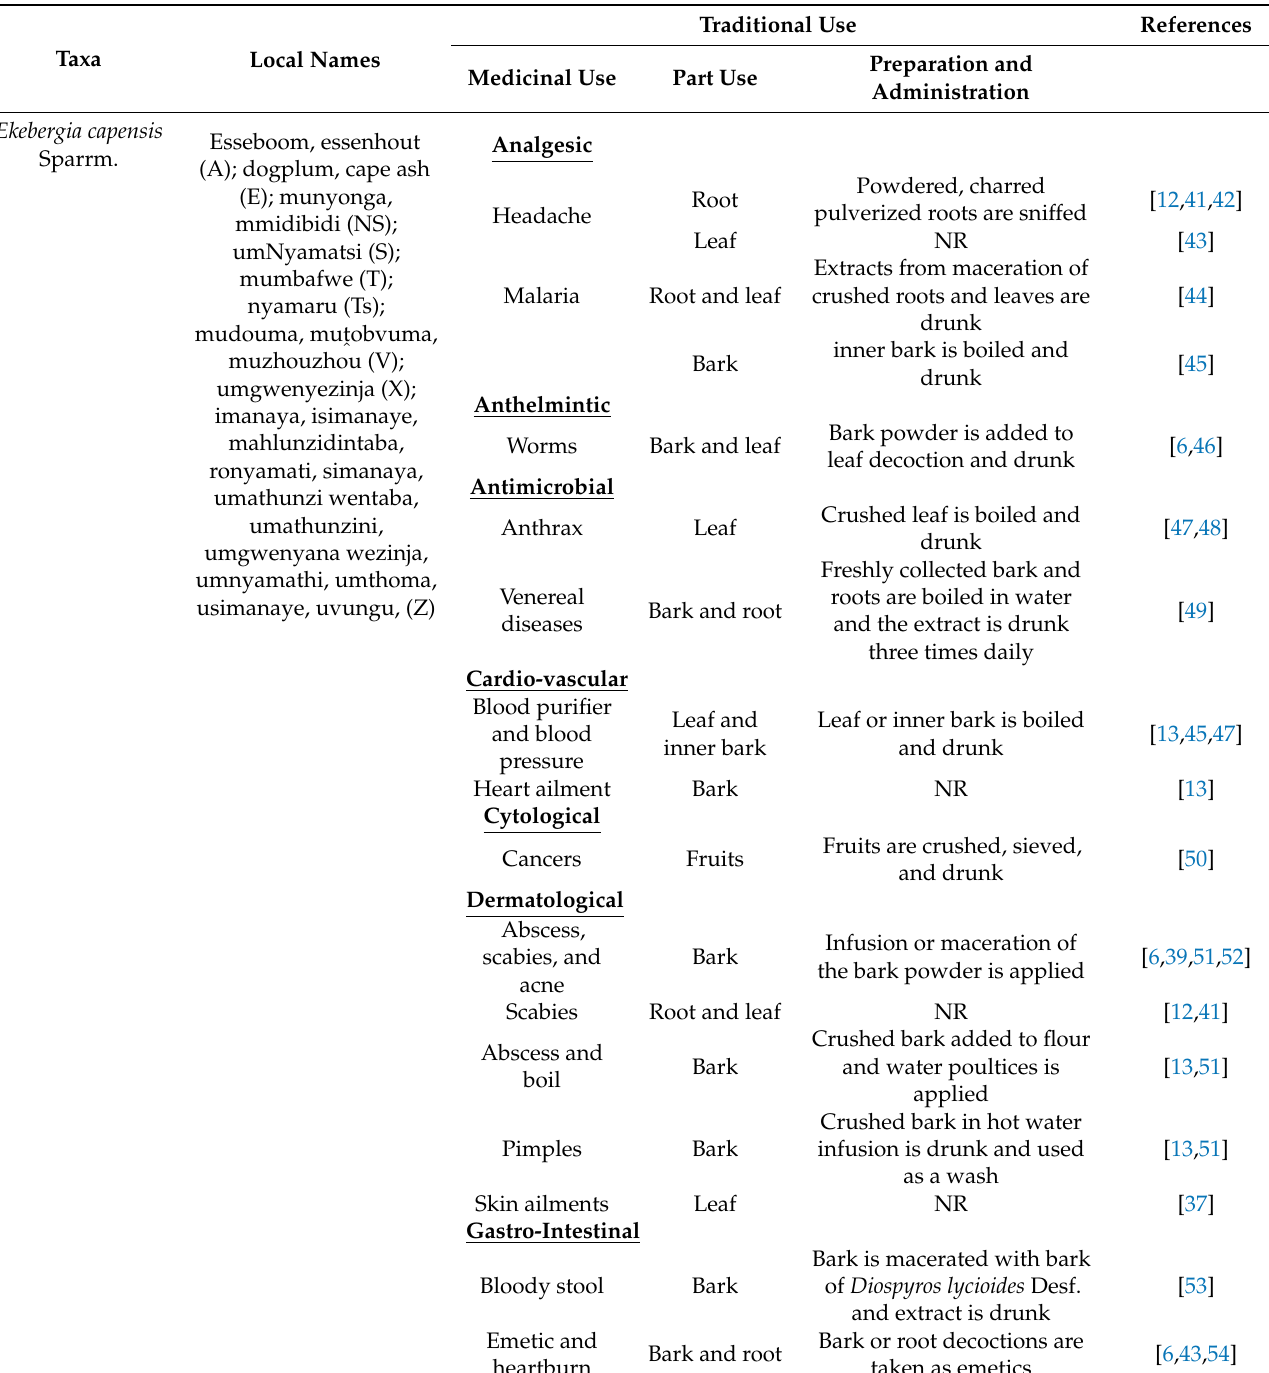
Table 1. The traditional uses of South African Meliaceae. The categories are according to Moffett’s (2010) classification. *NR: Not recorded; A: Afrikaans; E: English; N: Ndebele; NS: Northern Sotho; S: Sotho; Sh: Shona; T: Tsonga; Ts: Tswana; V: Vhavenda; X: Xhoza; Z: